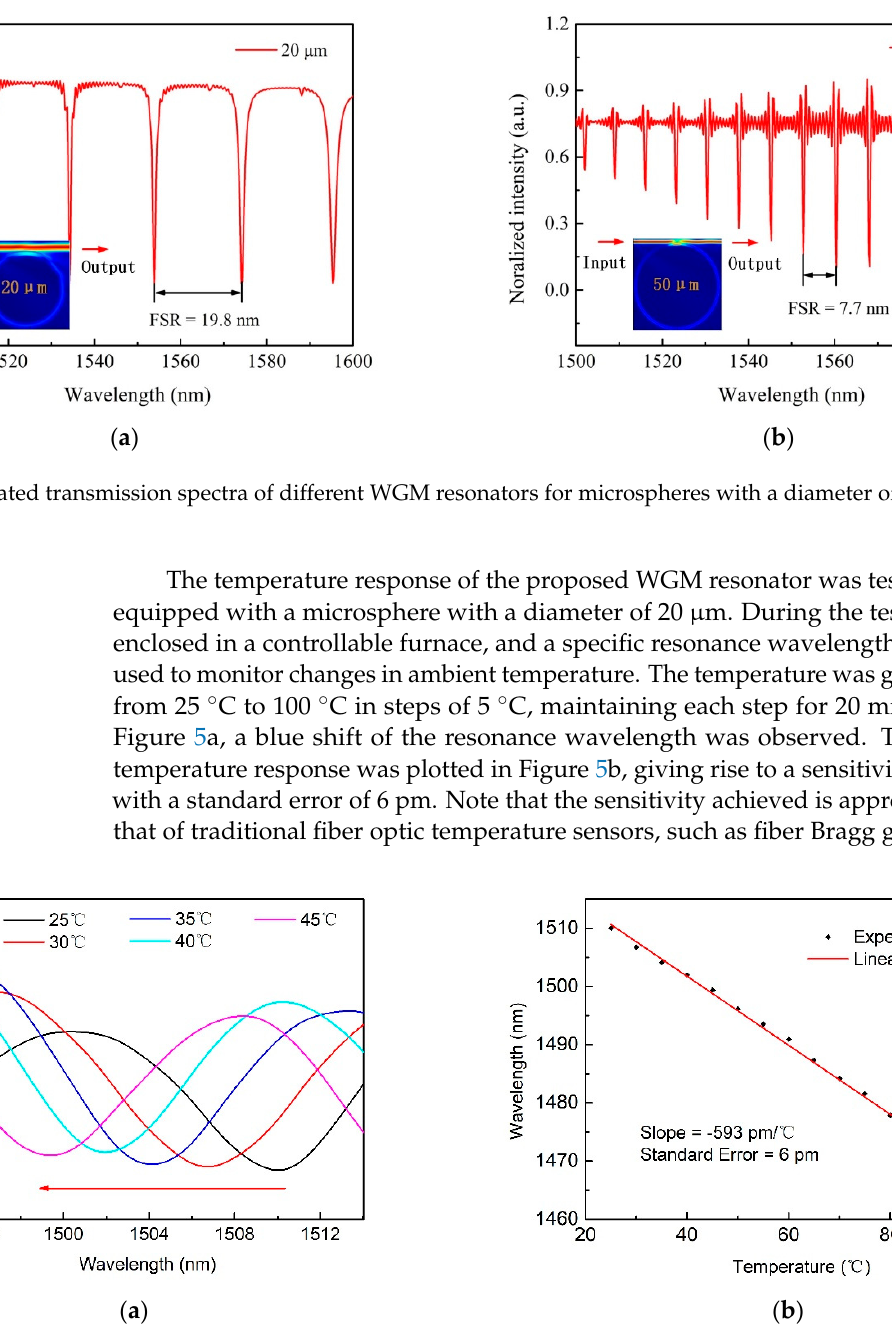
( b ) Figure 3. Detected transmission spectra before and after mounting a microsphere with a diameter of ( a ) 20 μ m and ( b ) 50 μ m.